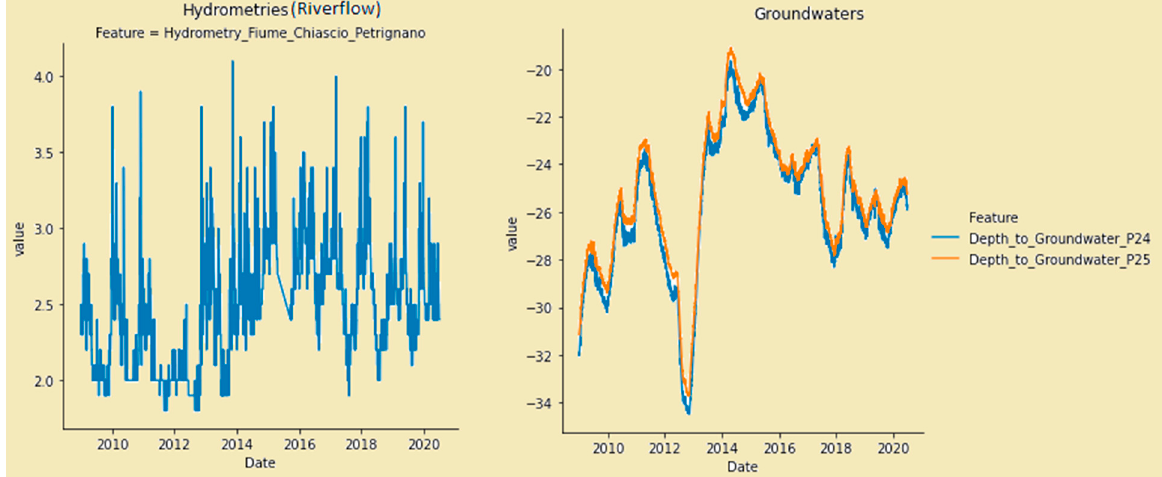
Figure 3. Variable distribution of the Petrignano-aquifer.